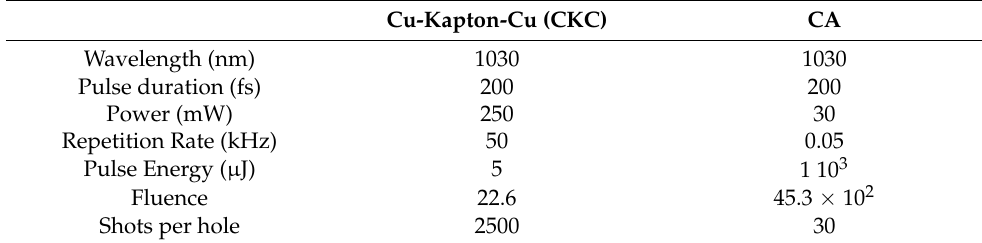
Table 1. Laser working